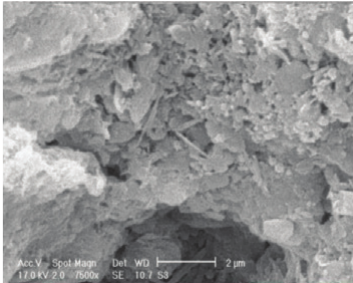
Fig. 14. Electron microscope image of the 7 day curing samples with 5% Lime and 1 %